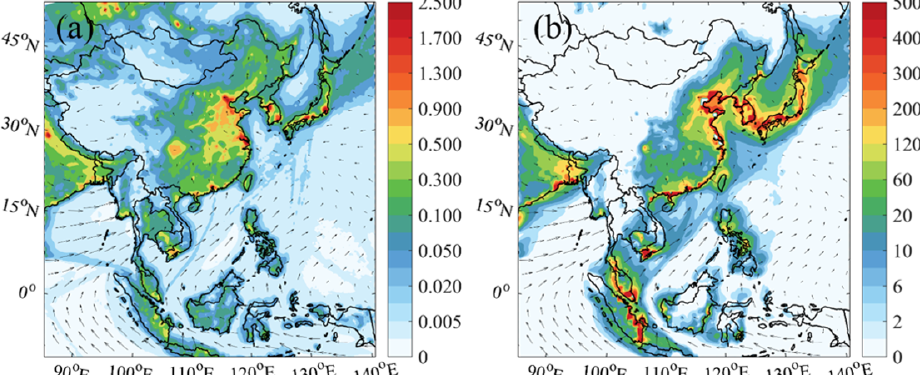
Figure 2. Spatial distributions of the simulation of averaged (a) HONO (in ppbv, whole day) and (b) night-time ClNO 2 (in pptv, 18:00– 06:00LST, local standard time) at the surface layer ( ∼ 30m) in July 2018 from the BASE case. The arrows present simulated wind vectors from the BASE case.